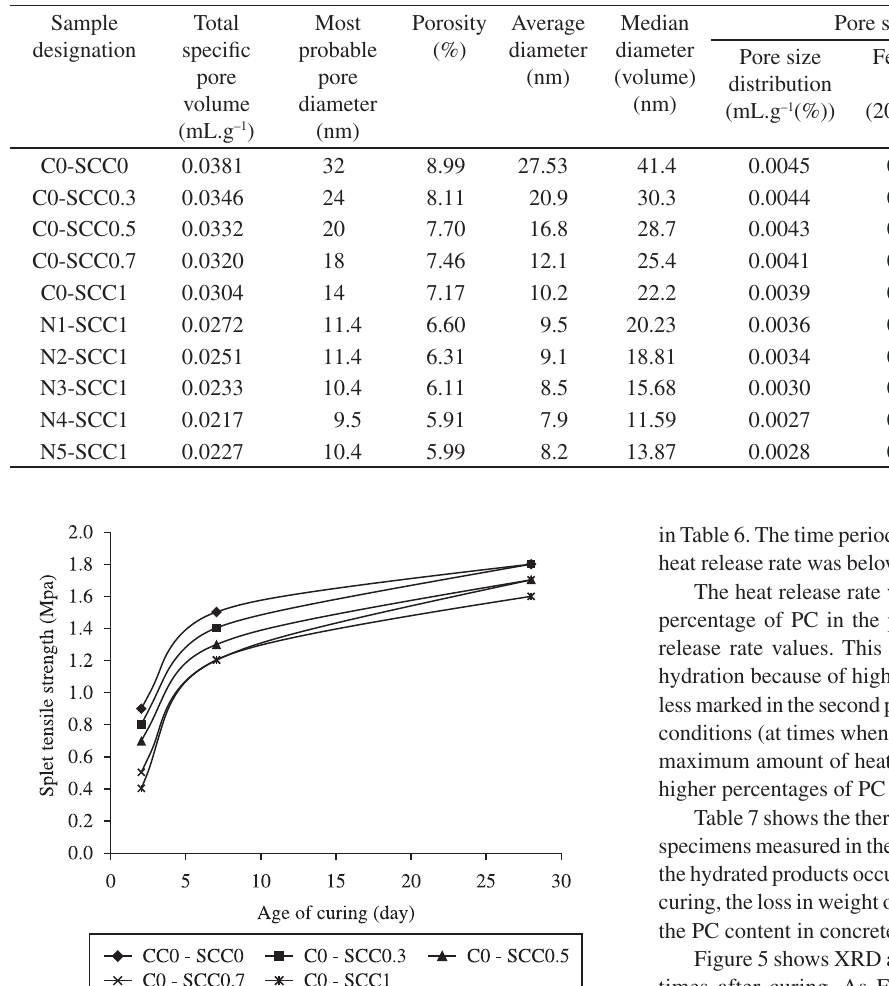
Figure 4. Split tensile strength of C0-SCC